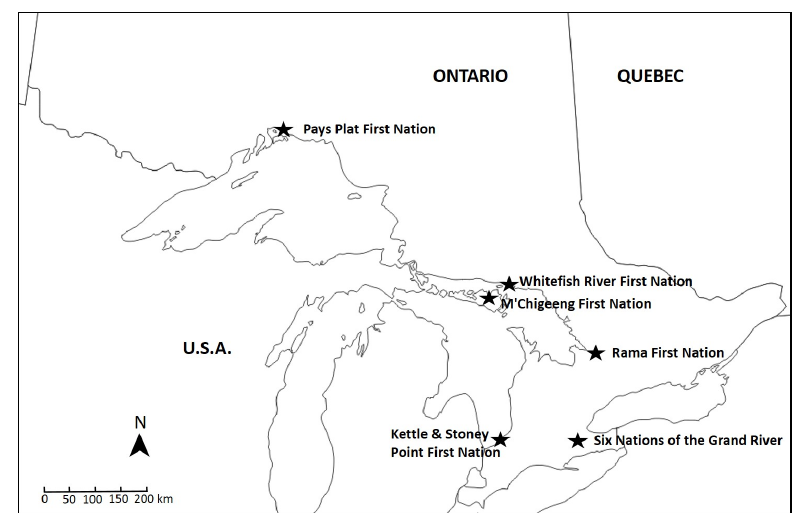
Figure 2. Location of the First Nations communities in Ontario discussed in this report.